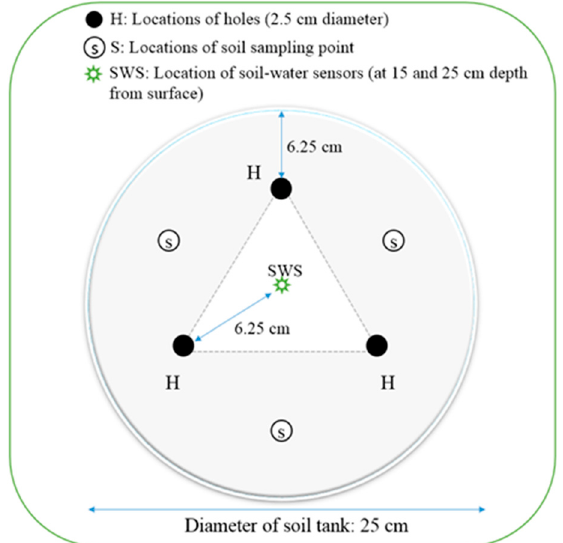
Figure 1. Schematic diagram of the top view of the soil tank indicating position of holes (only 3% of soil surface area) and soil sampling locations for total petroleum hydrocarbon (TPH) concentration and other parameters (70 cm long column containing 30 cm soil height).